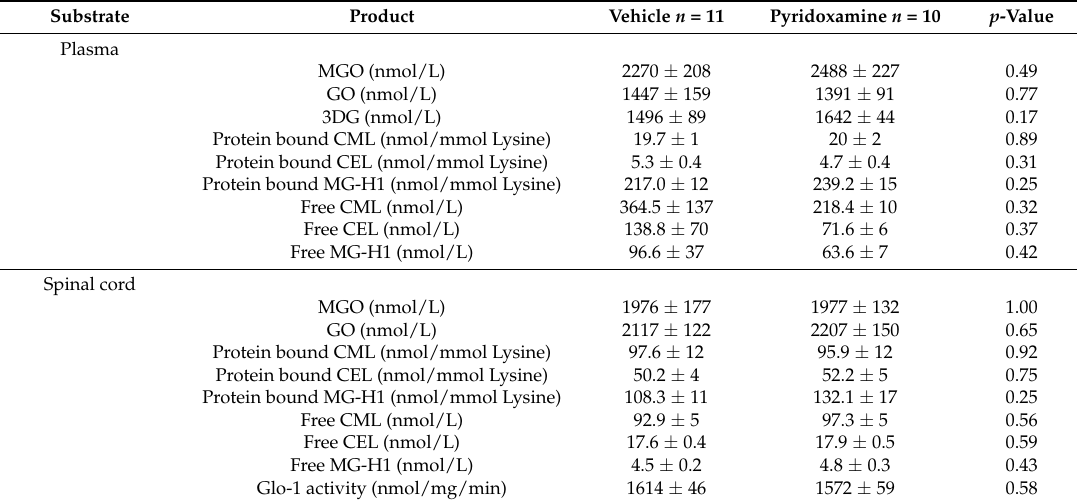
Table 2. Dicarbonyl and AGE levels in the plasma and spinal cord after daily oral vehicle or pyridoxamine (10 g/L) treatment during